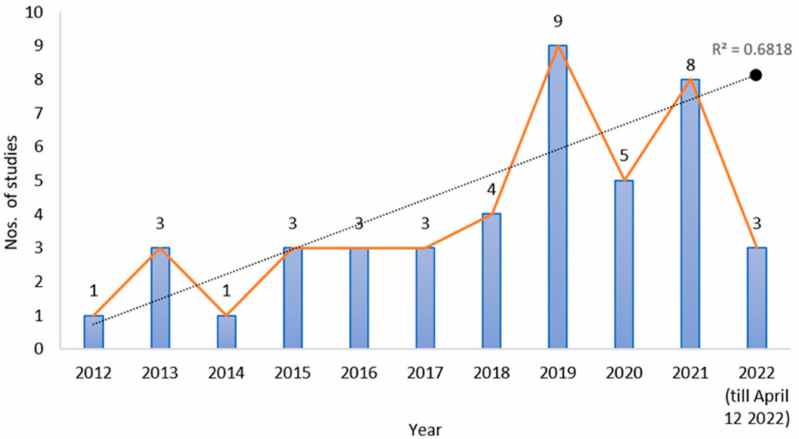
Figure 3. Temporal trend for the number of published studies regarding the subject (with 2022 forecasted).